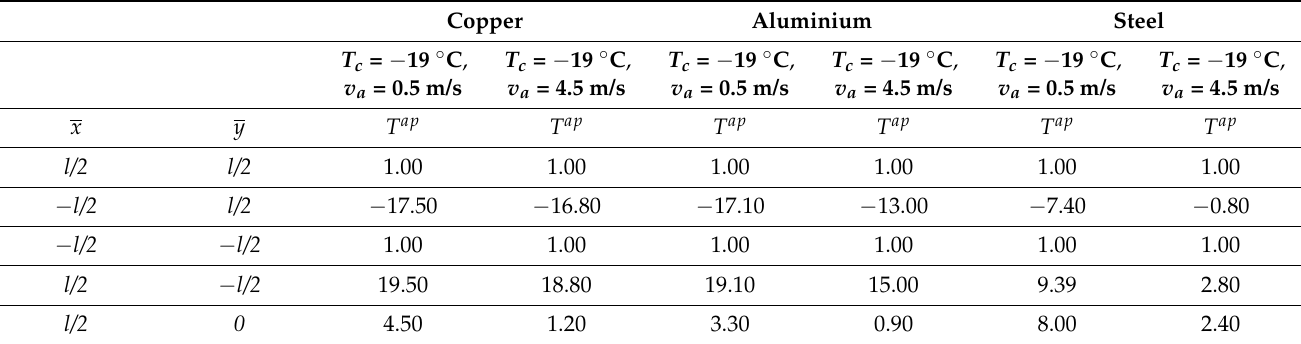
Table 9. Temperatures in the corners of different plates and at the midpoint of the plate’s surface facing the heated air inlet to the room for different values of T c , v a , t = 300 s, and T c = − 19 ◦ C.